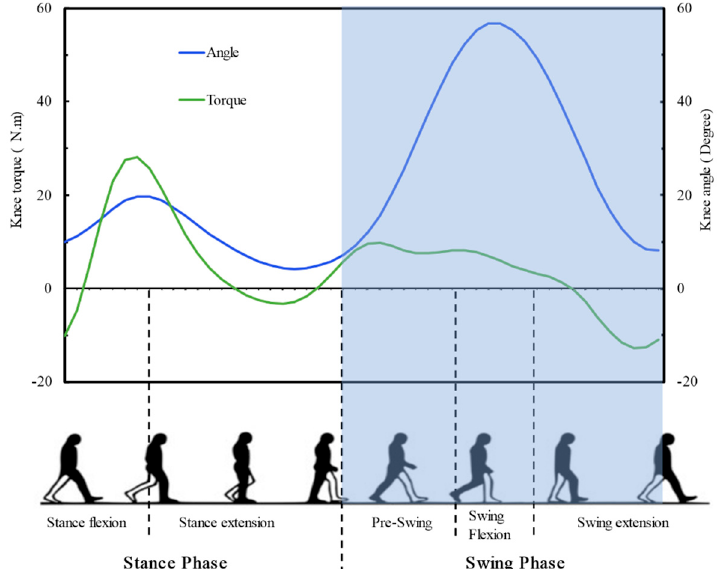
Figure 1. A complete gait cycle. The relationship of knee angle and torque.